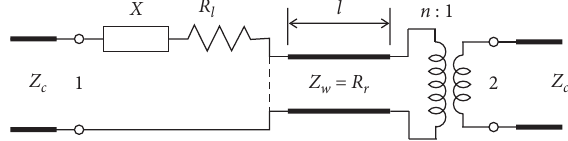
Figure 3: Equivalent circuit of a dipole in the form of a two-port